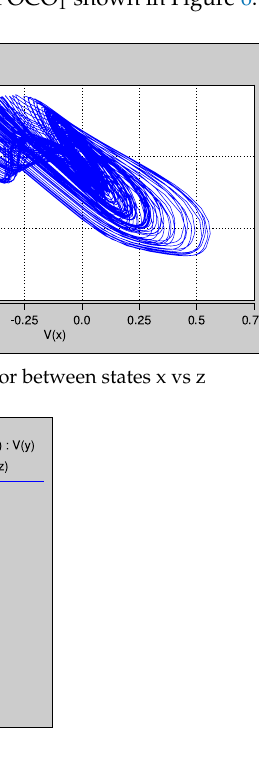
Figure 20. Layout of our proposed CMOS OTA-based FOCO 1 shown in Figure 6.